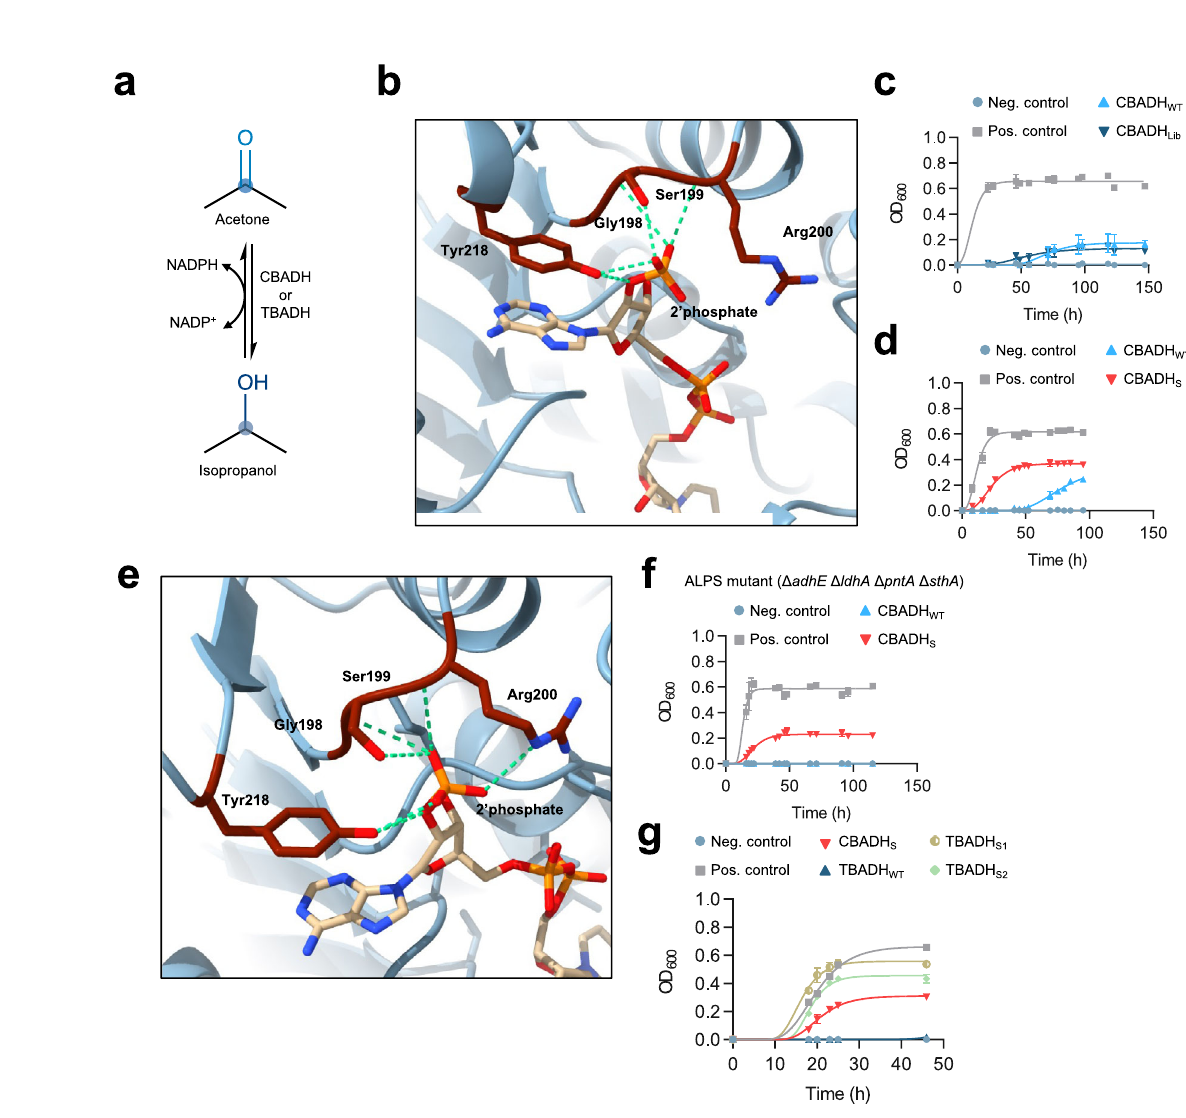
Fig. 2 Selection of alcohol dehydrogenases with reversed cofactor selectivity. a CBADH ( Clostridium beijerinckii alcohol dehydrogenase) and TBADH ( Thermoanaerobacter brockii alcohol dehydrogenase) catalyze the reduction of acetone to isopropanol exclusively using NADPH, as well as the reverse reaction. b Cofactor binding site of CBADH WT with NADPH bound (PDB code 1KEV). The S199, R200, and Y218 residues interact with the 2 ′ phosphate of NADPH. Hydrogen bonds are shown in green. c Anaerobic culture of, AL cells transformed with library CBADH Lib (pLS10) in M9 glucose medium supplemented with acetone. Controls are as in Fig. 1. CBADH WT (pLS6) was able to restore the slow anaerobic growth of AL cells due to the activity of transhydrogenases. d Anaerobic growth of AL cells transformed with CBADH S (with substitutions G198D, S199Y, and Y218P; pLS10_3) in medium with acetone. e Cofactor binding site of TBADH WT with NADPH bound (PDB code 1YKF). A similar set of residues as in CBADH establishes interactions with the 2 ′ phosphate of TBADH. Hydrogen bonds are shown in green. f Anaerobic culture of ALPS cells in medium supplemented with acetone. CBADH S , which can use NAD, supported anaerobic growth of ALPS. Unlike AL cells transformed with CBADH WT , ALPS cells transformed with CBADH WT did not grow anaerobically, due to the absence of any transhydrogenase activity to regenerate NAD + from NADP + . g Anaerobic culture of ALPS cells transformed with CBADH S , TBADH S1 (with substitutions G198S, S199K, R200P, and Y218V; pLS73_2), TBADH S2 (with a duplication of residues 191 − 241 and substitutions G198H, S199R, R200A, Y218M, G198 ’ A, and R200 ’ K; pLS73_1) or TBADH WT (pLS69) in medium supplemented with acetone. All NAD- utilizing variants supported the anaerobic growth of ALPS. TBADH WT , like CBADH WT , could not support the anaerobic growth of ALPS cells. Data points of growth curves represent mean values, with error bars showing standard deviation; n = 3 biologically independent cultures for all timepoints of growth curves. Source data are provided as a Source Data fi